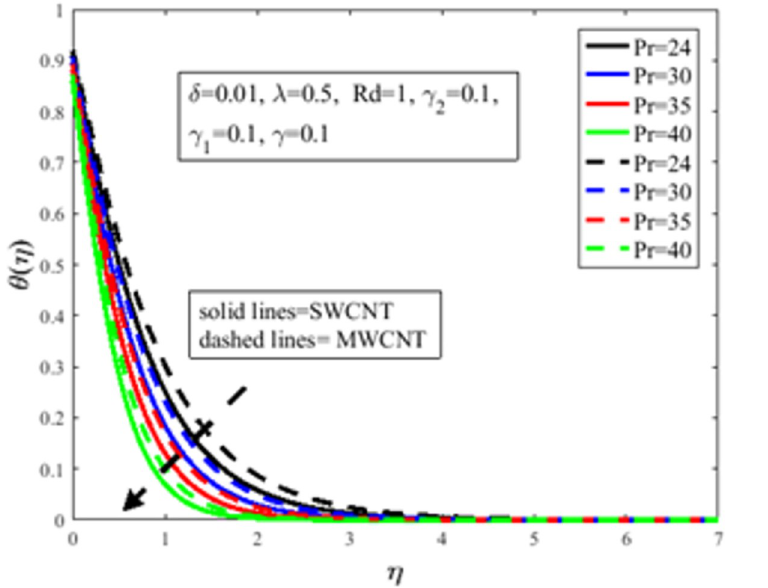
thermal boundary layer. It is well established, the thermal diffusion of the fluid diminishes result in an increase in Pr . The temperature of the fluid depreciates as a result of an abatement in the thermal diffusivity which furthermore guides to a decrement in θ ( η ). The characteristics of radiation parameter Rd on θ ( η ) are highlighted in Fig 11. Physically thermal radiation is used to enhance the heat transfer rate of the fluid having immense utilization in an industry like polymer production, combustion reactors, pasteurization, and remove toxic